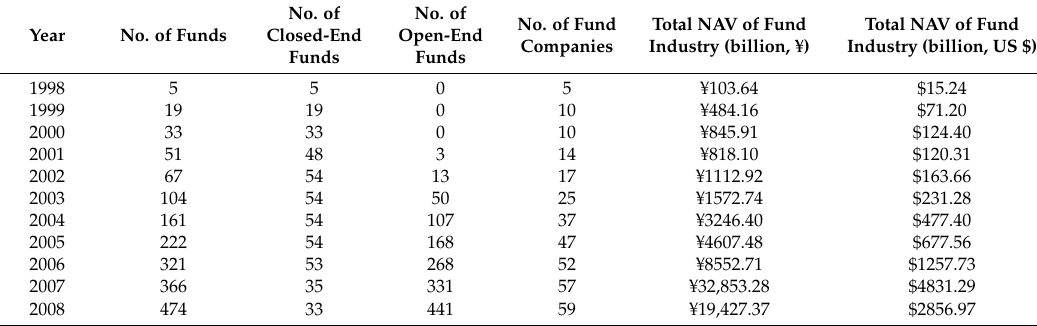
Table 1. Breakdown of Historical Data of the Chinese Securities Investment Fund